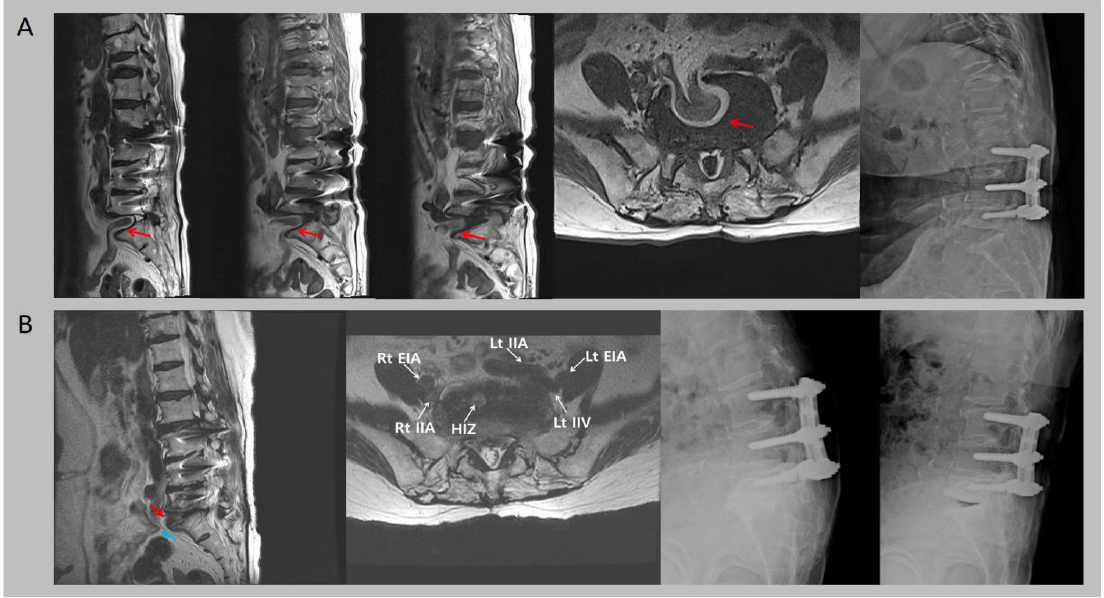
Figure 1. ( A ) T2-weighted lumbar spine magnetic resonance images (MRIs) on admission day reveal invagination of the small intestine (red arrows) into the intervertebral disc space of L5-S1. A lateral lumbar spinal X-ray performed on the day of admission shows the markedly increased lordotic angle at the L5-S1 level and a widened L5-S1 disc space. ( B ) T2-weighted MRI from 8 years ago reveals degeneration and a high-intensity zone (red arrow) on the L5-S1 intervertebral disc, and flexion and an extension lateral X-ray showed spinal segmental instability at L5-S1. Blue arrow: small bowel